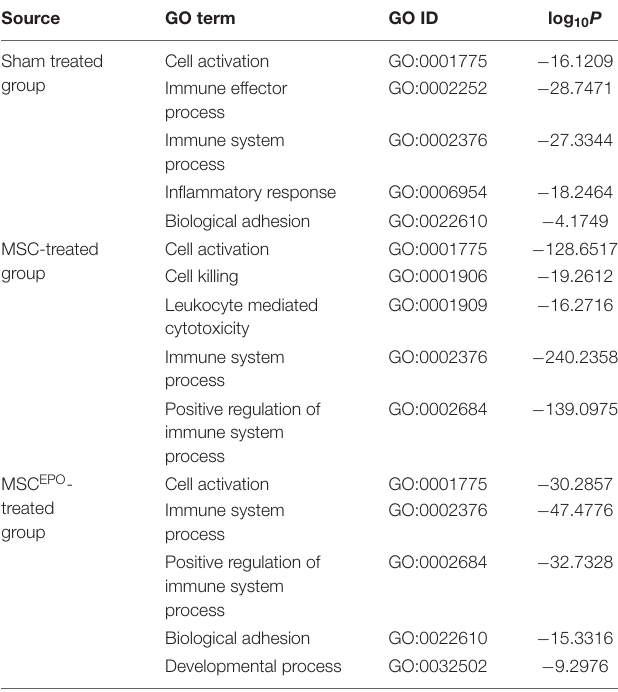
TABLE 1 | Over-representation analysis on the list of DEGs was performed using g:Profiler and then summarized using REViGO. The top 5 representative GO biological processes were tabulated ( P ≤